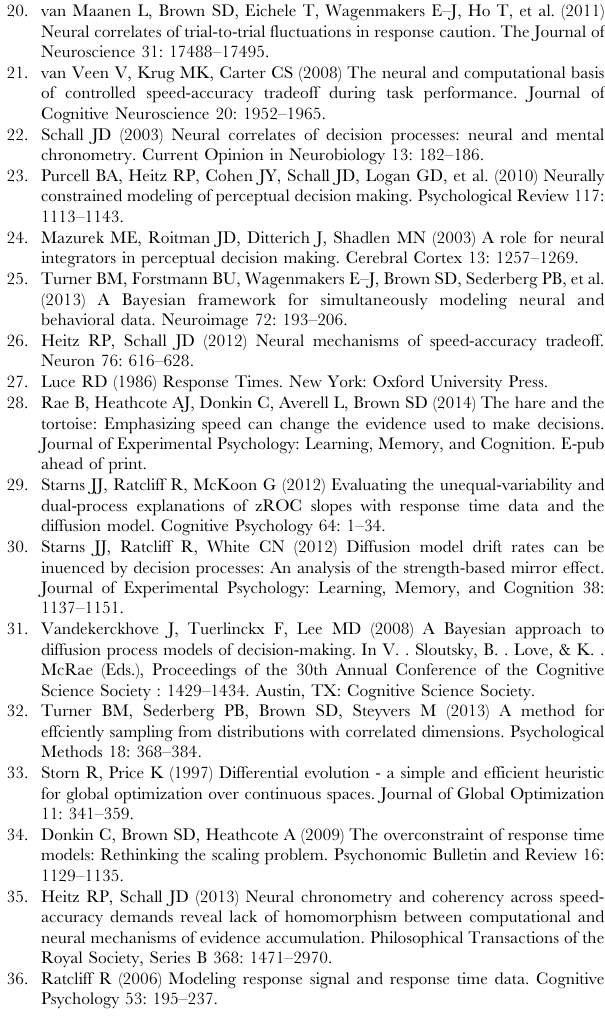
Figure S1 Markov chain Monte Carlo sampling chains for each parameter, for monkey Q and S. Only burnt in samples are displayed (10000–15000 iterations). Figure S2 Marginal posterior distributions over each parameter for monkey Q and S. Figure S3 Resultant fit for an over–constrained version of the model variant in the main text. Probability distribution functions over response time and choice. Observed data, plotted as coloured histograms. Model posterior prediction distributions are overlaid as lines. Figure S4 Sample accumulation trajectories, for monkey S, for the accumulator corresponding to a neuron with a target in its receptive field. To correspond with neural data, only trajectories corresponding to correct decisions are displayed. Mean trajectories overlaid as heavy lines. Left panel displays paths aligned on stimulus onset. Right panel displays paths aligned on response.